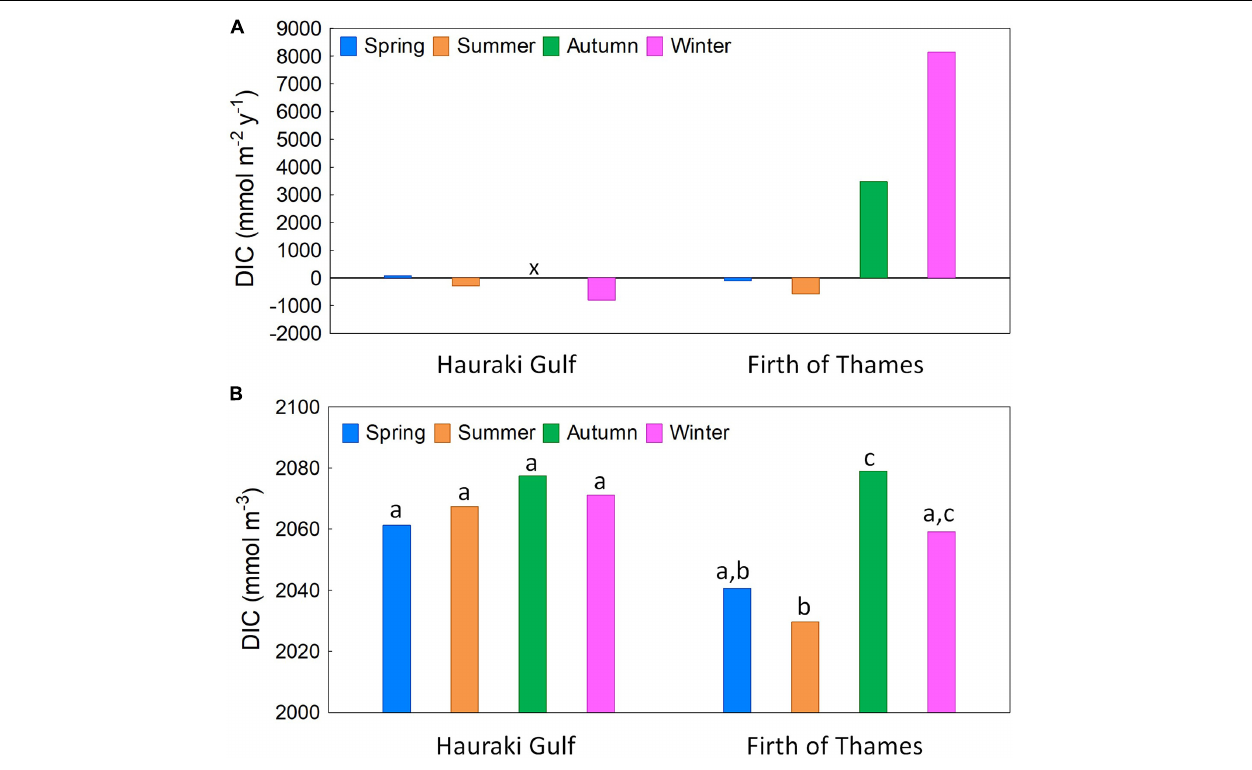
FIGURE 11 | (A) Seasonal water column-average net DIC fluxes (mmol DIC m − 2 y − 1 ) in Hauraki Gulf and Firth of Thames regions from the mass-balance budget of Zeldis and Swaney (2018) (see Figure 1B for mass balance box delineations). The mass balance estimate for the Hauraki Gulf in autumn (“x”) could not be calculated (Zeldis and Swaney, 2018). (B) Seasonal water column-average DIC concentrations (mmol DIC m − 3 ) in Hauraki Gulf and Firth regions from the present study. Within each region, seasonal concentrations with different letters were significantly different ( p < 0.05; Neuman-Keuls multiple